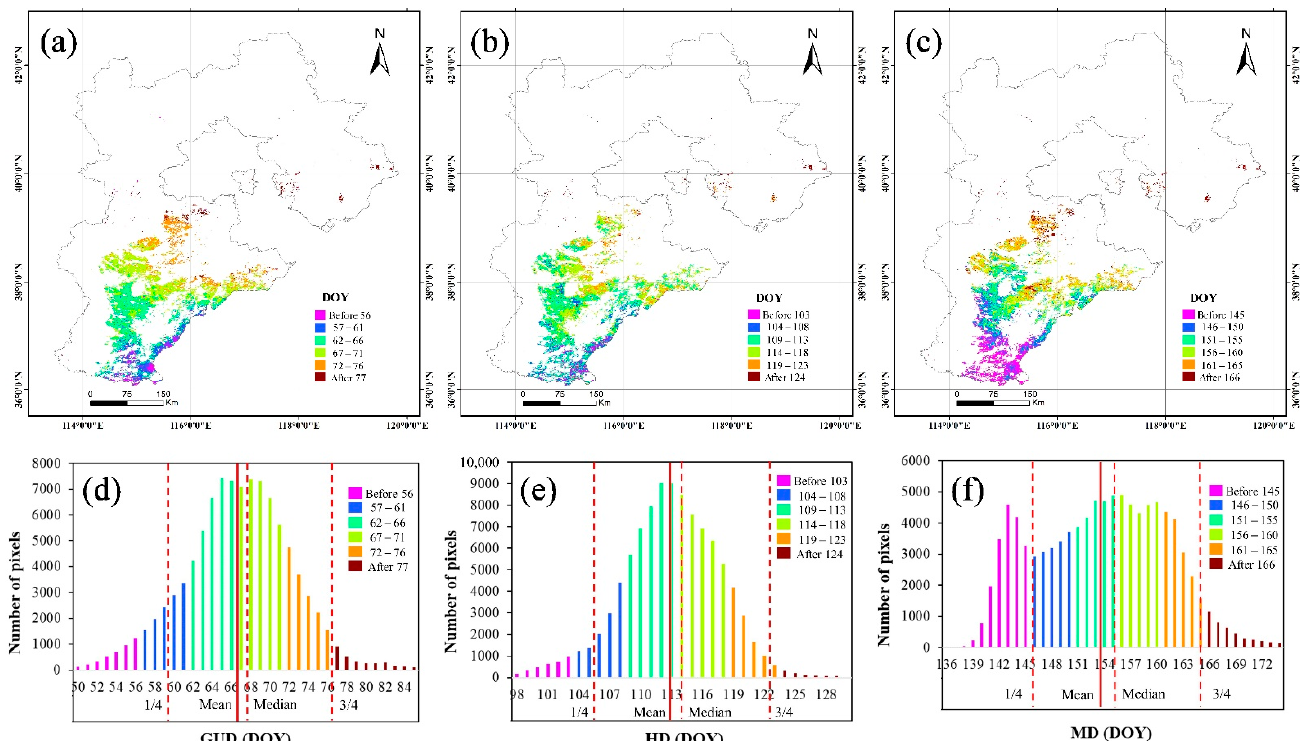
Figure 8. The spatial distribution of winter-wheat phenological phases for ( a ) GUD, ( b ) HD, and ( c ) MD, and frequency distributions for ( d ) GUD, ( e ) HD, and ( f ) MD.